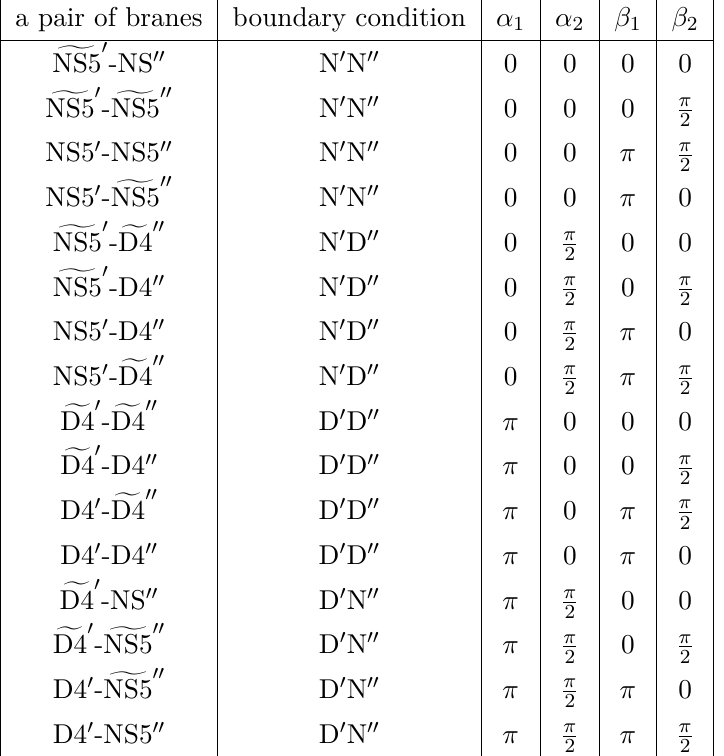
Table 1 . The phases ( α 1 , α 2 , β 1 , β 2 ) appearing in the fermionic quarter BPS boundary